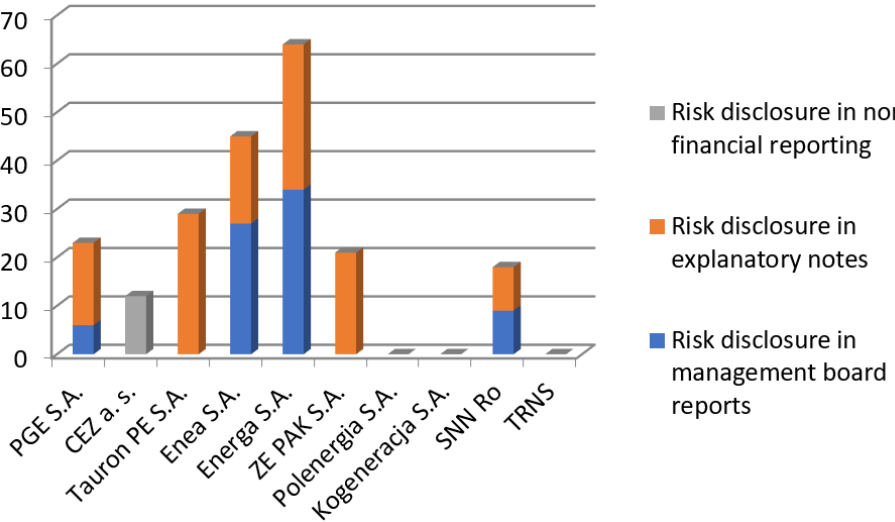
Figure 1. The Structure of Risk Disclosure by Companies in 2019.